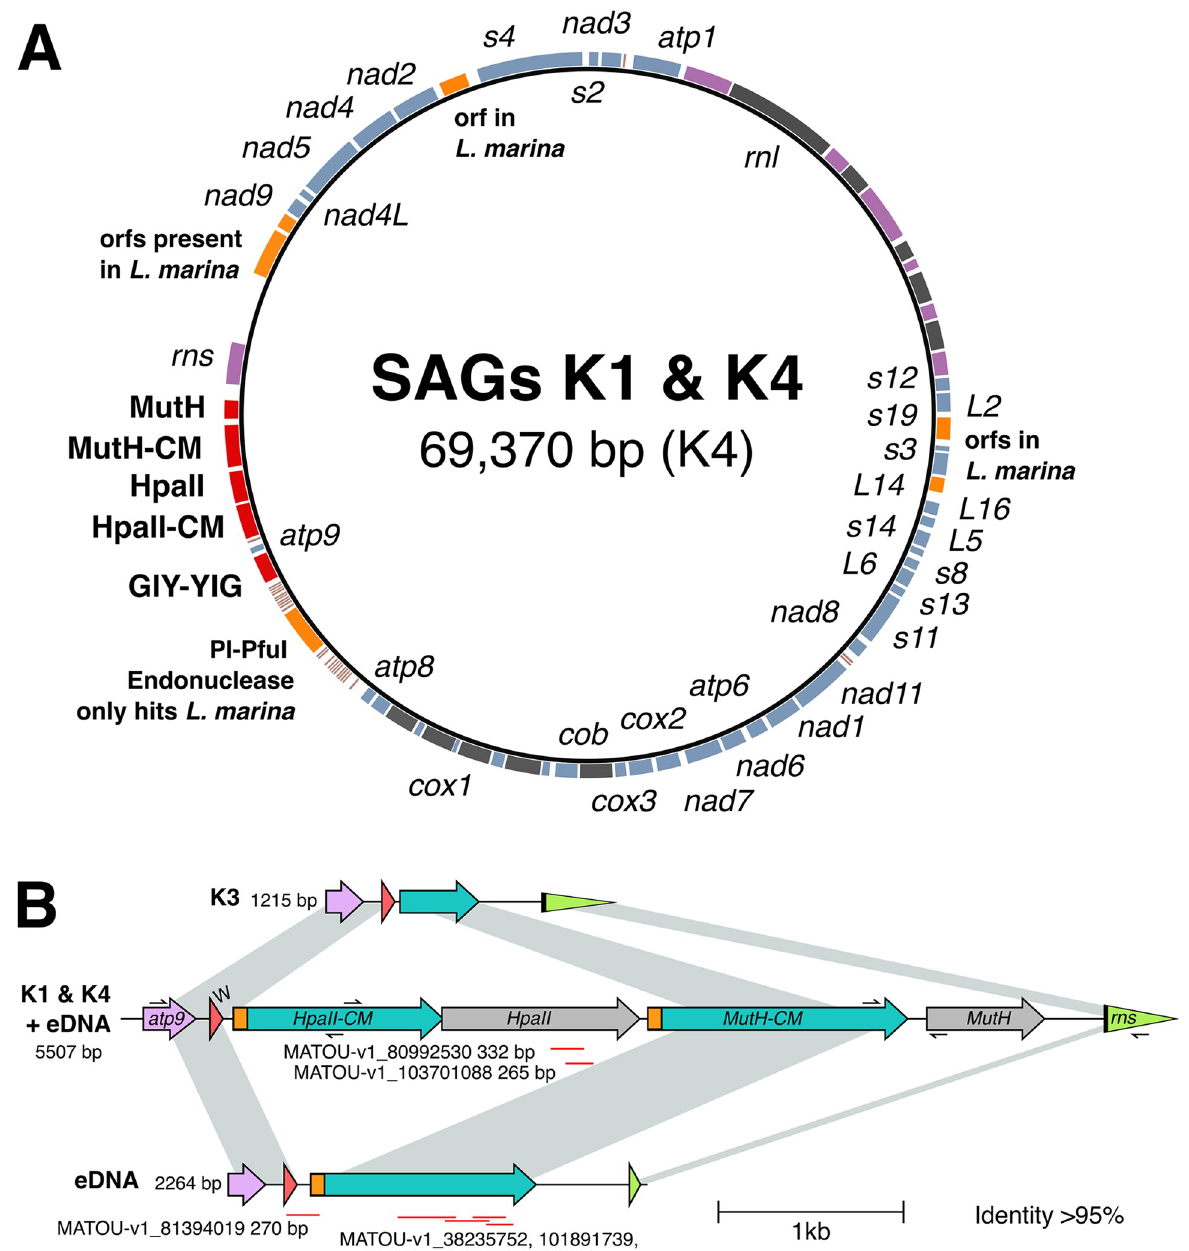
Fig 1. The katablepharid K1 and K4 mitochondrial genomes encode two tandemly encoded RM systems. (A) The K4 mitochondrial SAG encodes six ORFs (orange) with homologues in L . marina but with no similarity to any other eukaryote. Five ORFs are found in K4 but not in L . marina (red). These five genes include a putative GIY-YIG homing endonuclease and two putative RM systems, each consisting of an endonuclease and a CM. Blue, protein-coding genes; purple, rRNA genes; grey, introns. K1 and K4 mitochondrial genome contig data available at https://doi.org/10.6084/m9.figshare.7314728. (B) Variation in selfish elements detected in single amplified genomes and eDNA. PCR followed by Sanger sequencing was performed to confirm integration of selfish element genes in K1, K3, and K4 SAGs (primer positions indicated by arrows). PCR of eDNA samples identified one product with high sequence identity (99.7%) to K4 and a shorter (2,264-bp) unique product that is intermediate in length compared to K3 and K4. Red lines represent meta-transcriptome hits (95% to 100% identity) identified from the MATOU transcriptome database ( S1 Data ). Gene name abbreviations: atp9 , ATP synthase 9 subunit; W, tryptophan tRNA; HpaII , HpaII endonuclease; CM , cytosine methylase; MutH , MutH endonuclease; rns , small subunit rRNA gene. Fig 1B was generated using Clinker [31] and modified by hand. ORF colours do not correspond between Fig 1A and 1B . CM, cytosine methyltransferase; eDNA, environmental DNA; ORF, open reading frame; RM, restriction modification; SAG, single-cell amplified genome.